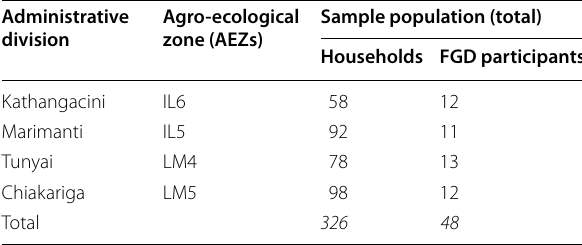
Table 1 Sample population by study sites Administrative